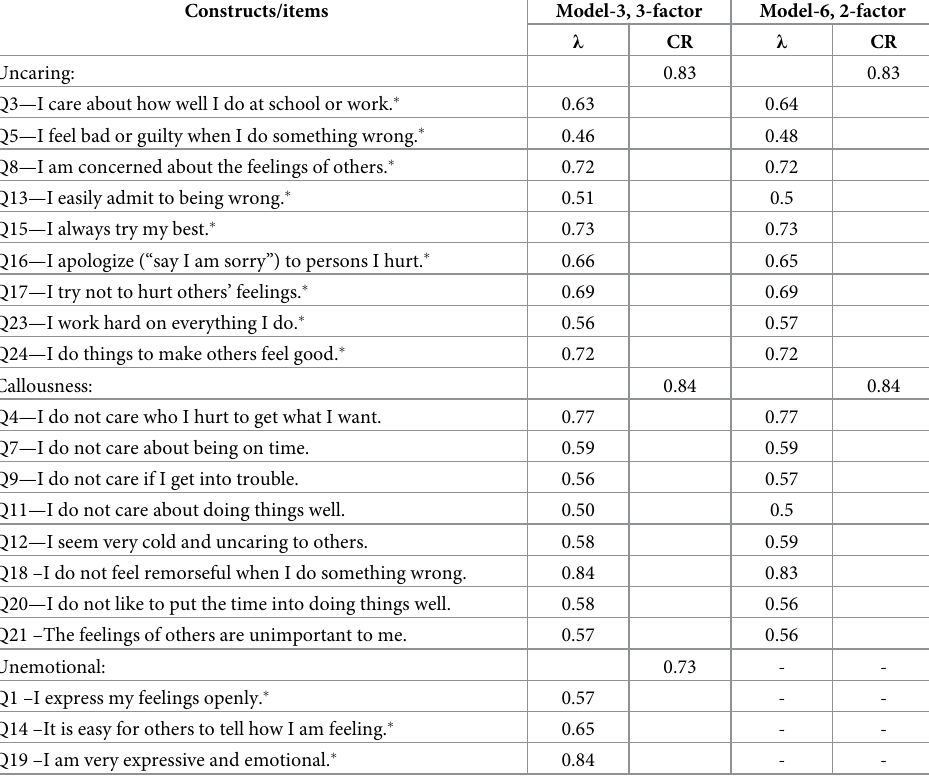
Table 4. Standardised factor loadings and construct reliability (CR) for Model-3 and Model-6.